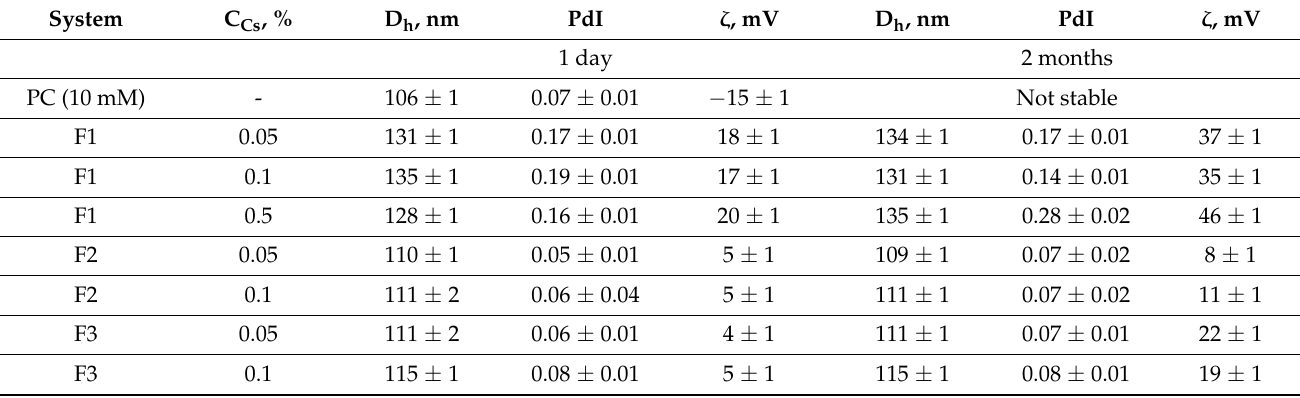
Table 2. Physicochemical characteristics of Cs-coated PC liposomes, with various concentrations of polymer (0.05–0.5%) and storage time: Hydrodynamic diameter (D h , nm), polydispersity index (PdI), and zeta potential ( ζ , mV); 25 ◦